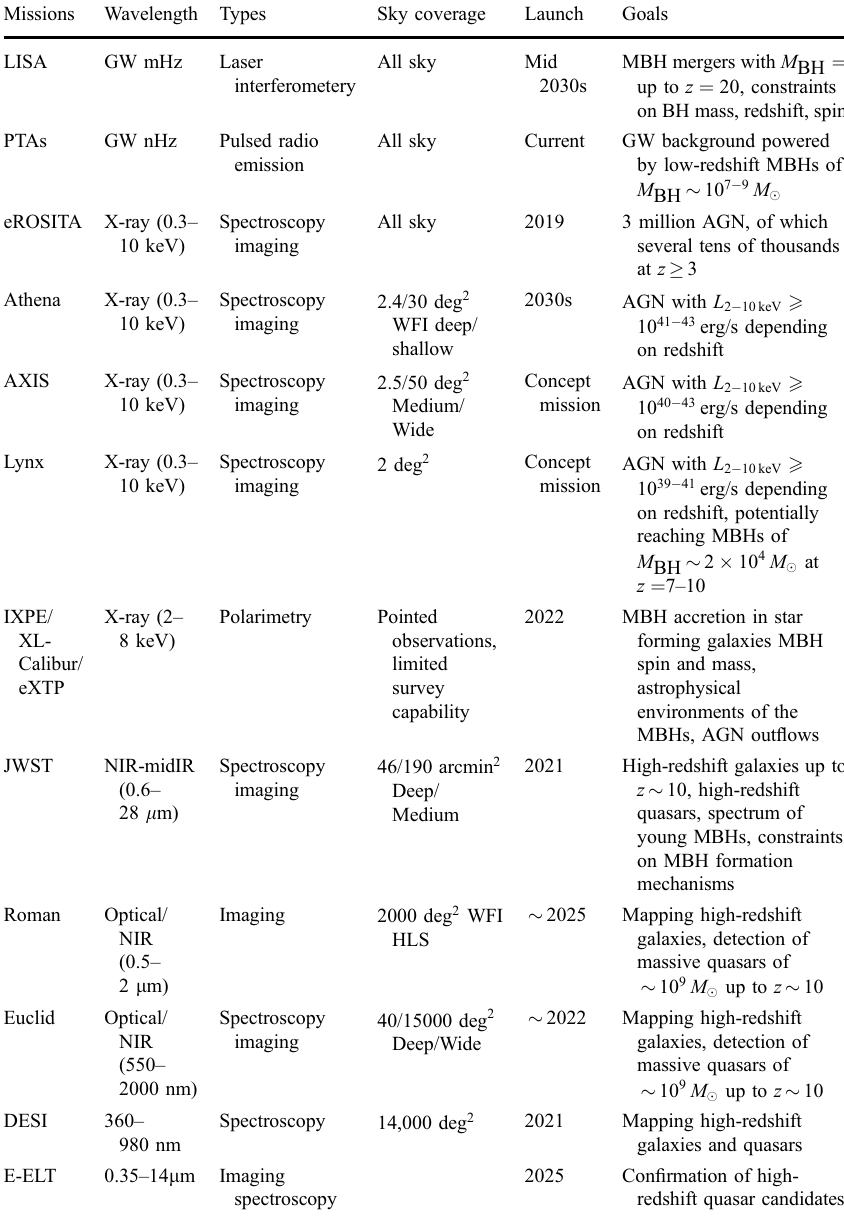
Table 7 Landscape of the upcoming and concept missions that will be complementary to LISA, and will provide us with crucial constraints on the population of MBHs and their host galaxies